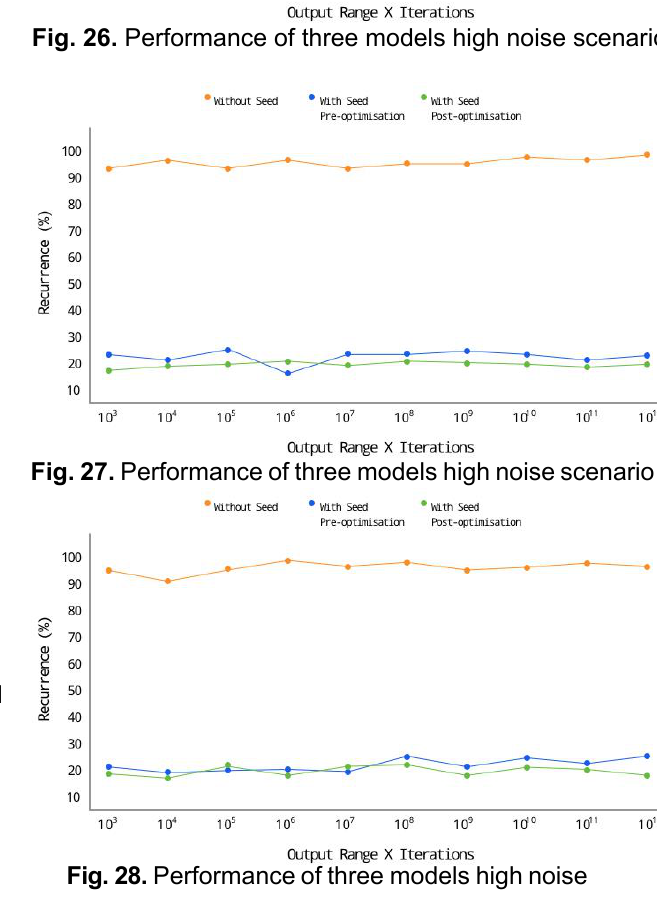
Fig. 28. Performance of three models high noise scenario